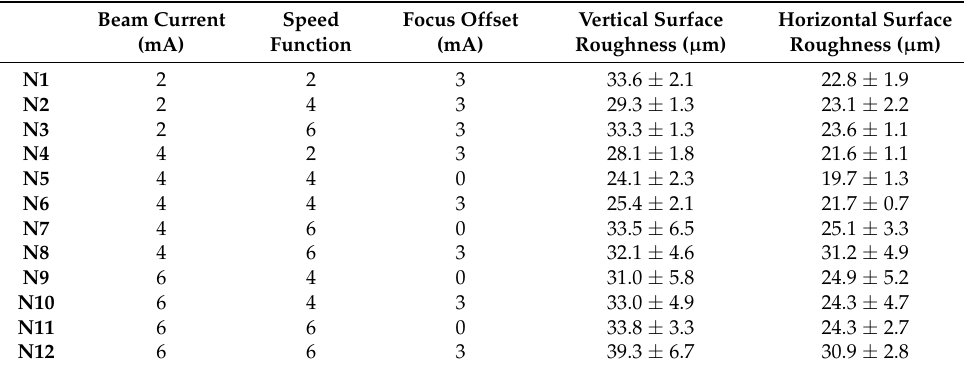
Table 1. Surface roughness results of non-multispot contouring. All the average values and standard deviations were obtained by measuring at least five